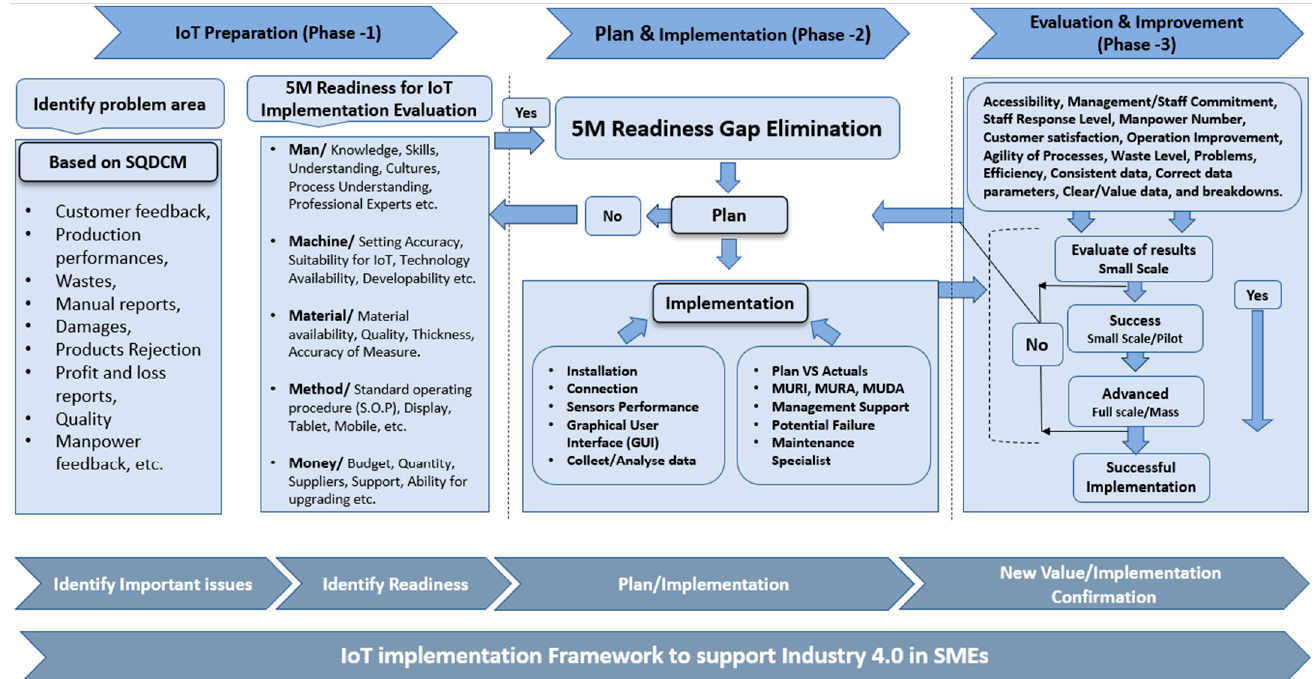
Figure 2. IoT implementation framework to support Industry 4.0 in